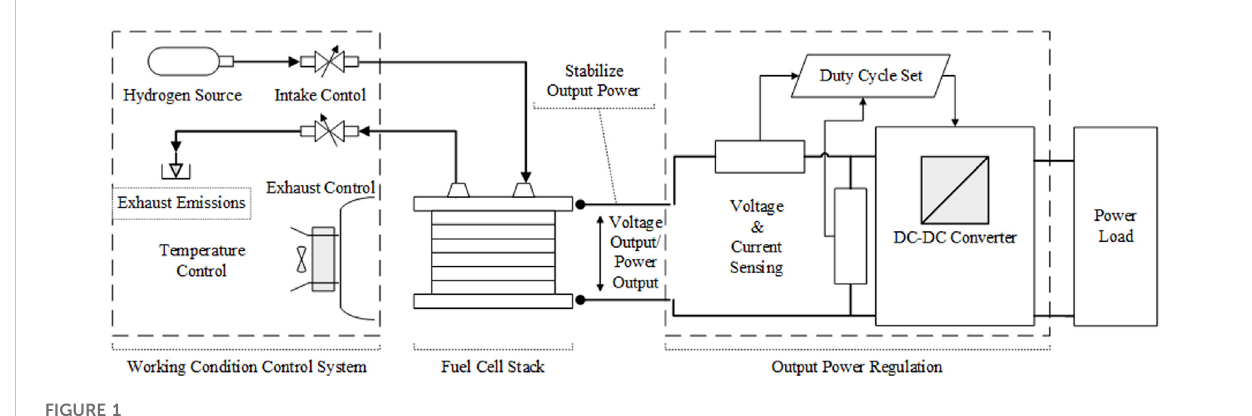
Structure of portable fuel cell power